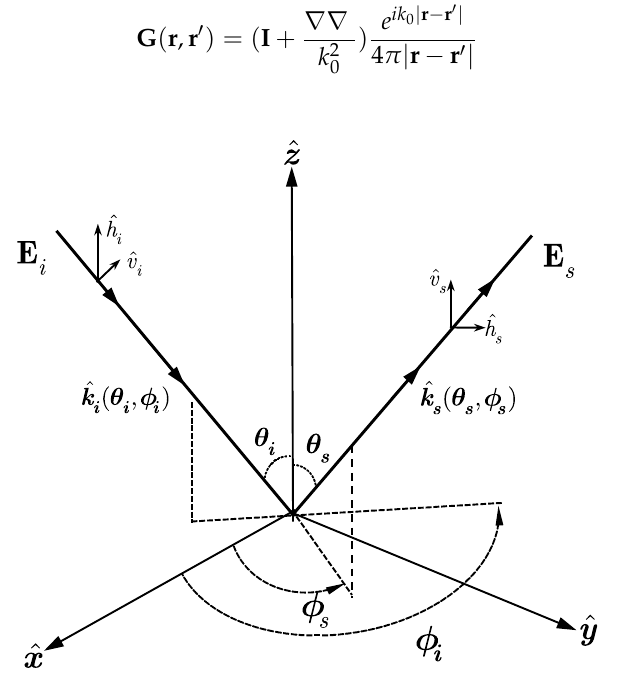
Figure 1 . Scattering geometry with forward scattering alignment (FSA). Figure 1. Scattering geometry with forward scattering alignment